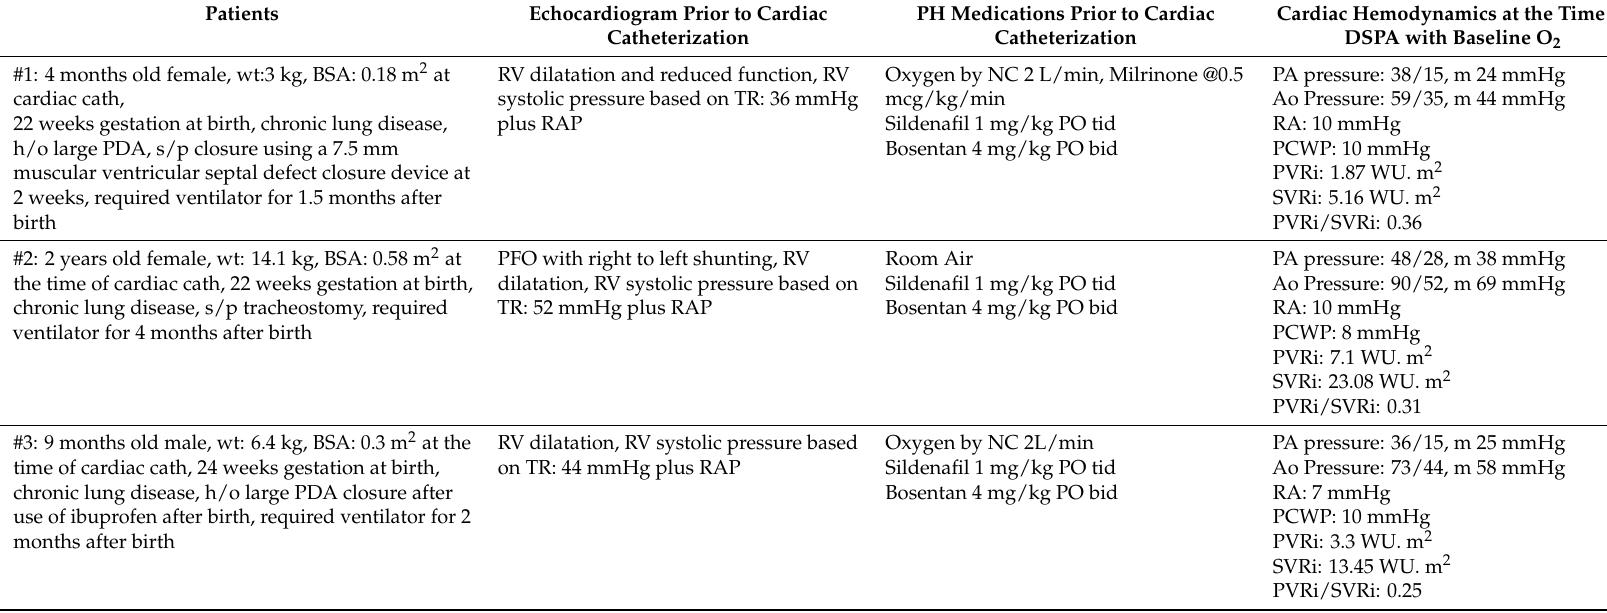
Table 1. Summary of Clinical and Hemodynamic